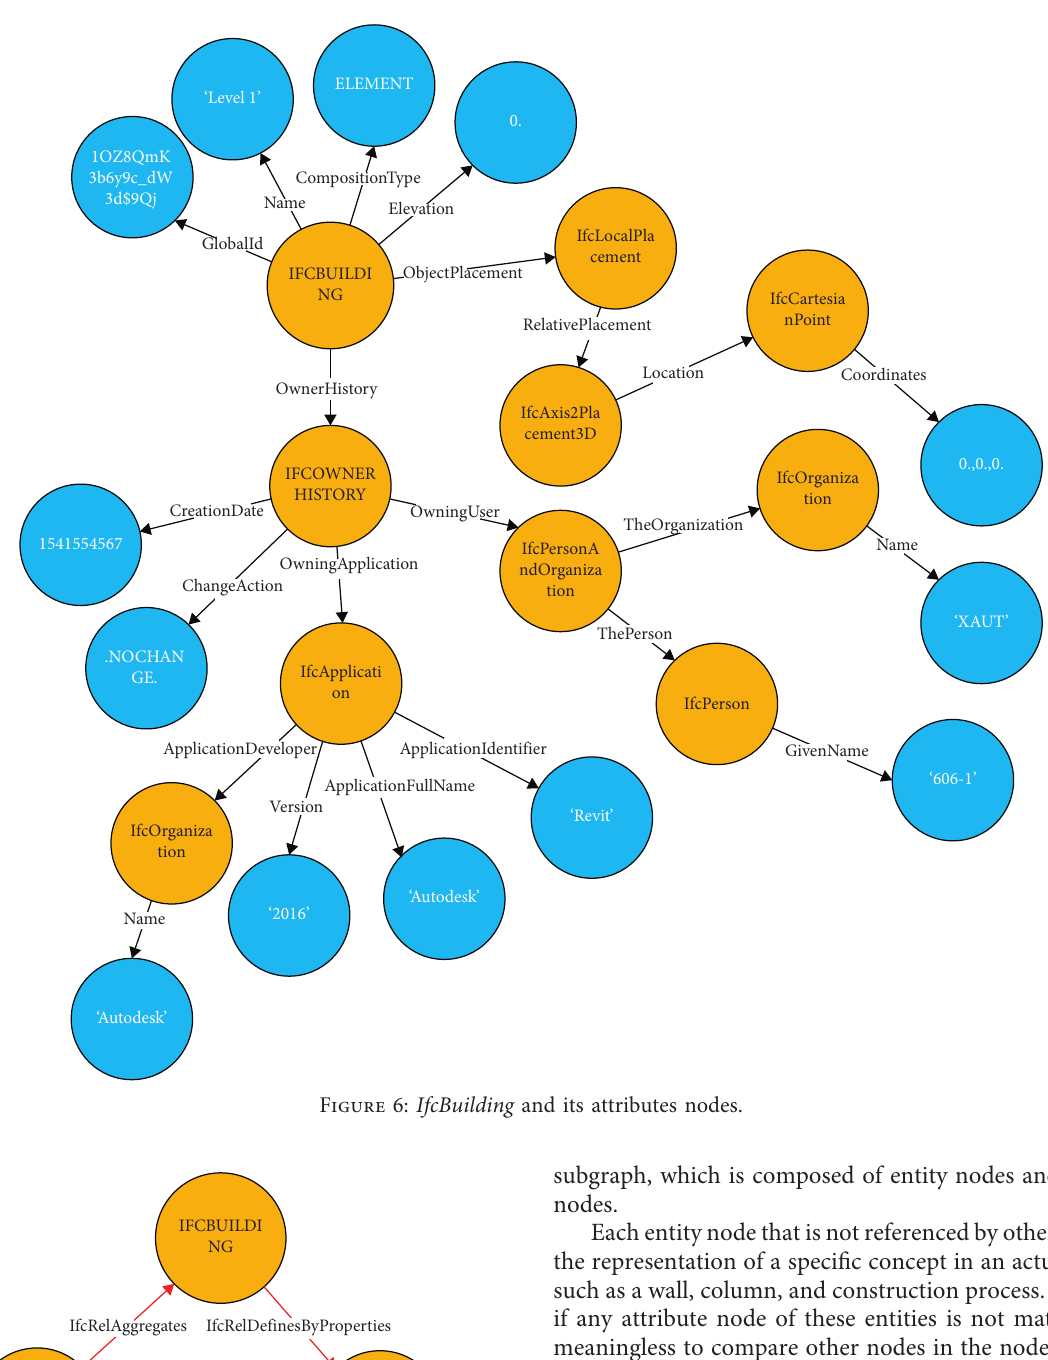
Figure 6: IfcBuilding and its attributes